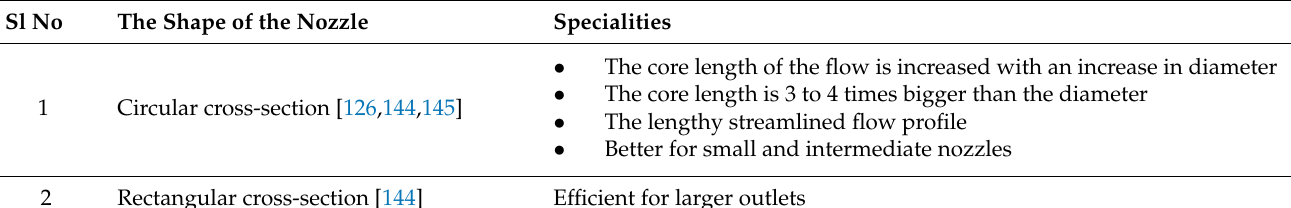
Table 13. Specialities of the nozzle